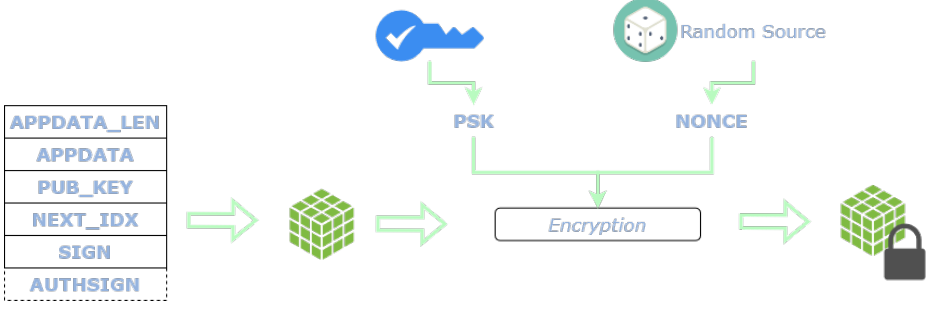
Figure 7. Encryption of an L2Sec